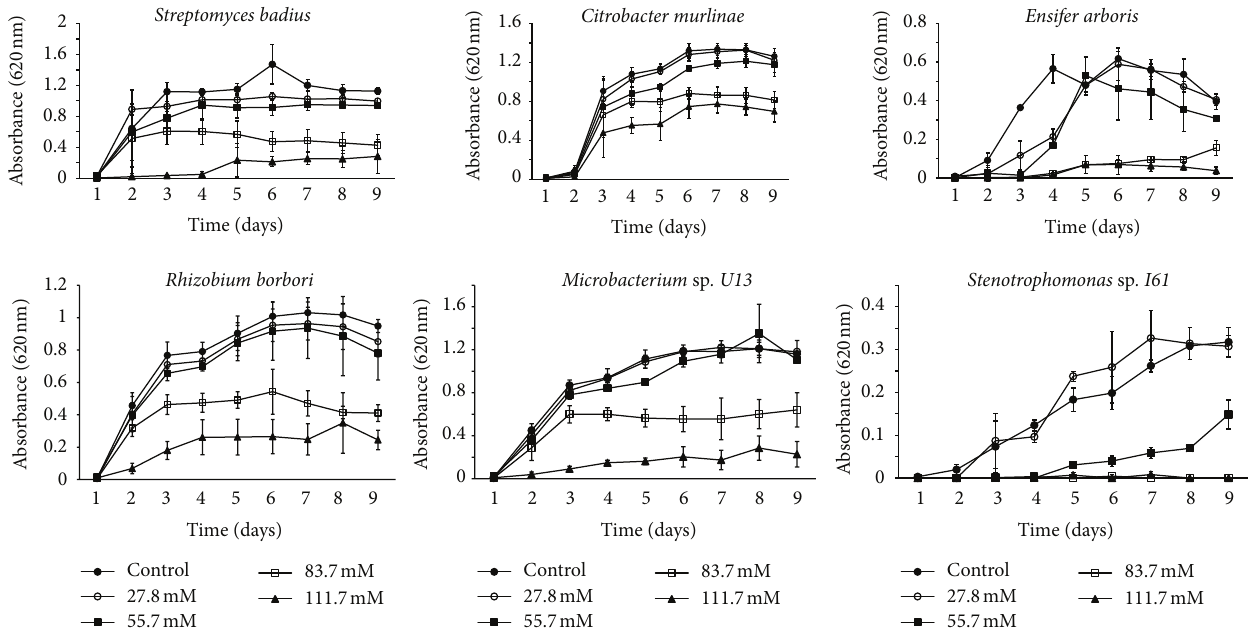
Figure 2: Growth curves for environmental isolates. Each isolate was cultured in TSB amended with varying concentrations of sucralose. The open circle indicates the positive control, closed circle is the 27.8mM group, the closed square is the 55.3 mM group, the open square is the 83.7 mM group, and the closed triangle is the 111.7mM group. The positive control group consisted of no sucralose added to the TSB in order to ascertain normal growth. This was performed to determine the effect that sucralose had on bacterial growth. The 83.7 mM and 111.7mM concentrations were significantly ( 𝑃 < 0.05 ) inhibited compared to the control group for each isolate. The 55.3 mM concentration was significantly ( 𝑃 < 0.05 ) inhibited compared to the control group for Stenotrophomonas sp. and Ensifer arboris .